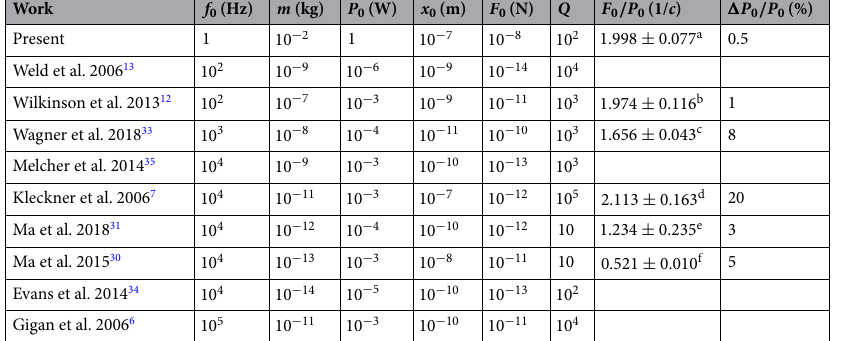
Table 1. Comparison of the orders of magnitudes of characteristic physical quantities, i.e., mechanical frequency f 0 , effective oscillator mass m , laser power modulation amplitude P 0 , peak displacement amplitude x 0 , force amplitude F 0 , and quality factor Q , in the present and selected previous works on the measurement of optical forces with mechanical oscillators. For direct comparability, the quantities in the table are obtained by fitting the harmonic oscillator response function of Eq. (3) to the experimental data corresponding to Fig. 2a or Fig. 2b of the present work. In the column for the optical force per power, F 0 / P 0 , the uncertainties do not account for the uncertainties in the determination of the optical power, which is separately shown in the last column. a Determined from the slope of the line in Fig. 2d. b Determined as F 0 / P 0 , where F 0 = kA 0 with k being the spring constant obtained from the nanoindenter and the off-resonance amplitude A 0 = 2 P 0 /( m ω 2 0 c ) is obtained from the quantities given in Table I of the reference. c Determined from the values in Table 1 of the reference as F sho / P c . d Determined as F 0 / P 0 , where F 0 = kA rad with given values for the spring constant k determined from the thermal vibration spectrum and for the off-resonance amplitude A rad . e Determined from Fig. 3(b) of the reference at 750 nm. The value is much lower than 2/ c due to the transmission and absorption which reduce the reflectivity. f Determined from the slope of the line fitted in the experimental data of Fig. 4 of the reference. The value is much lower than 2/ c due to the partial transmission which reduces the